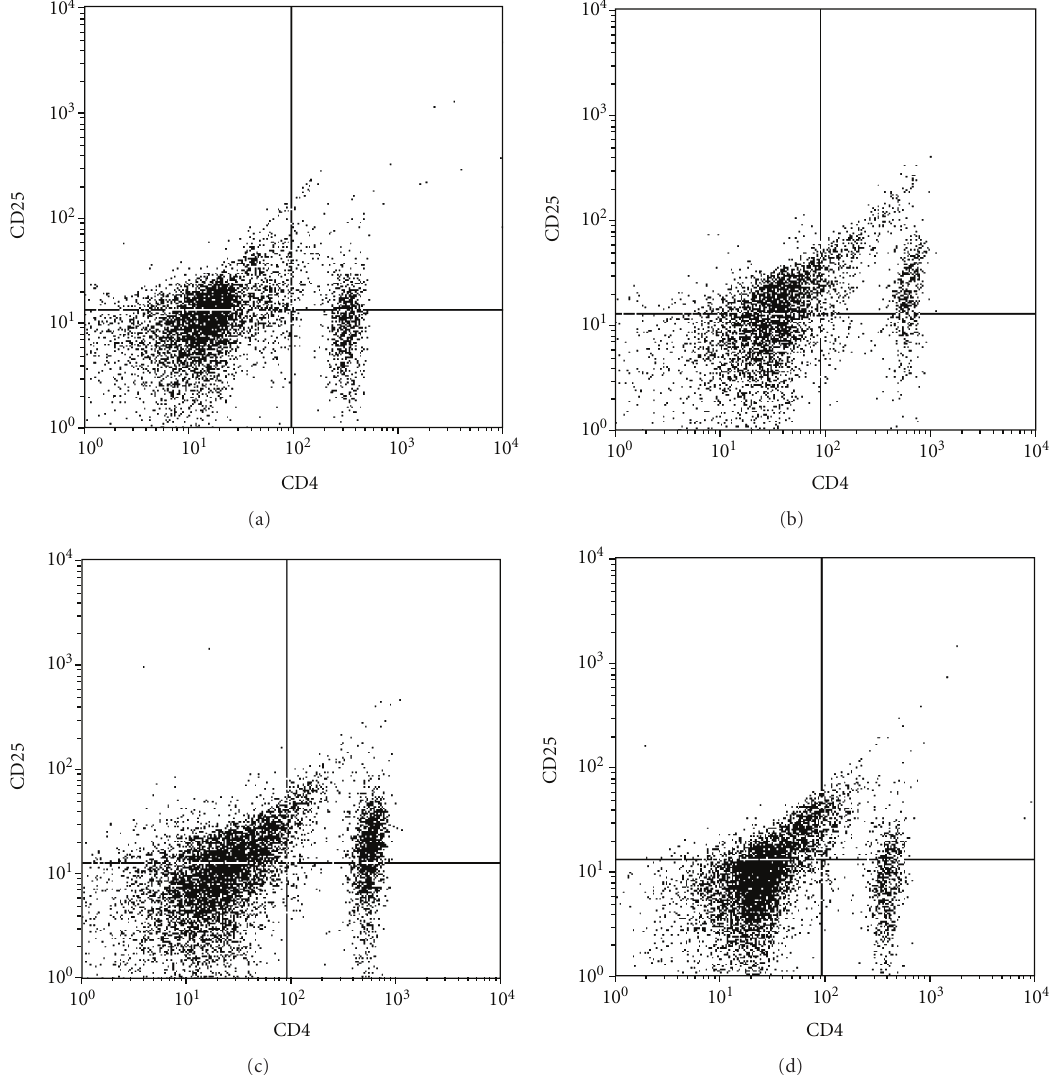
Figure 1: CD4 + CD25 + Treg changes of peripheral blood in rats (%) (a) MC group; (b) NC group; (c) TPT group; (d) MTX group.